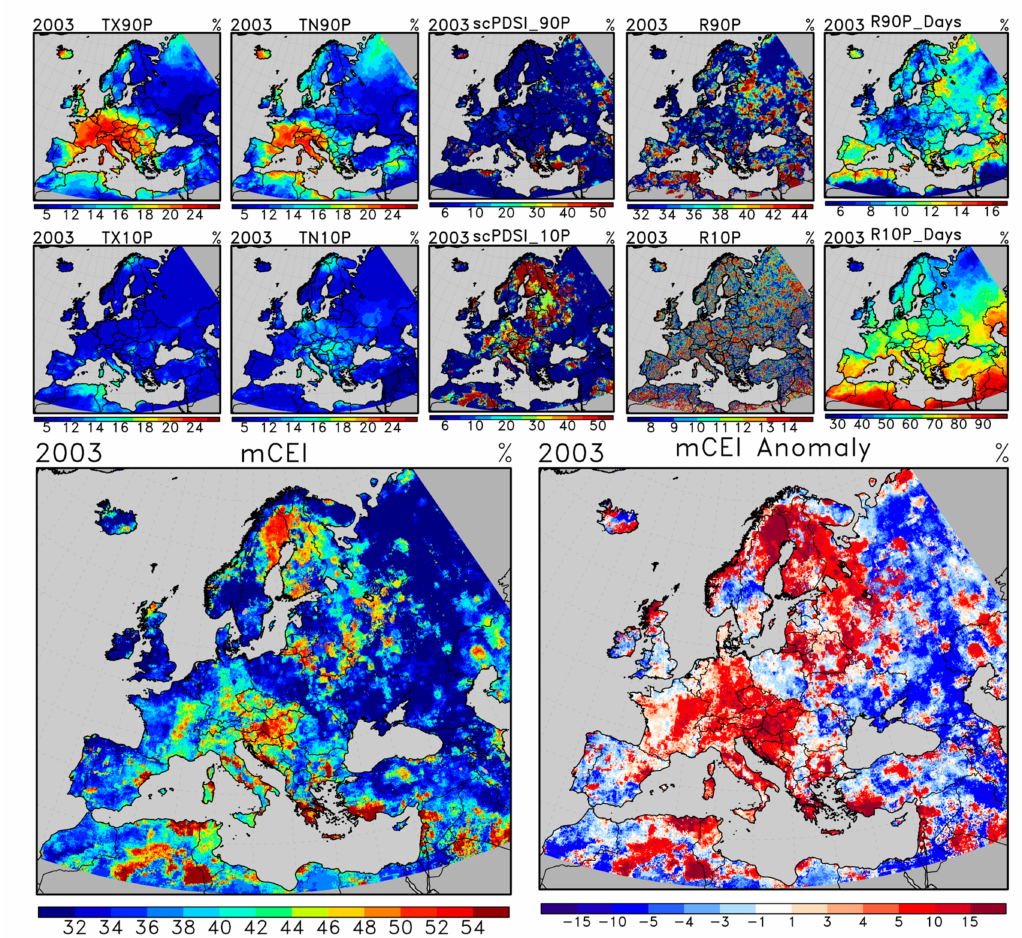
Figure 10. Extreme indexes, mCEI, and mCEI anomaly for